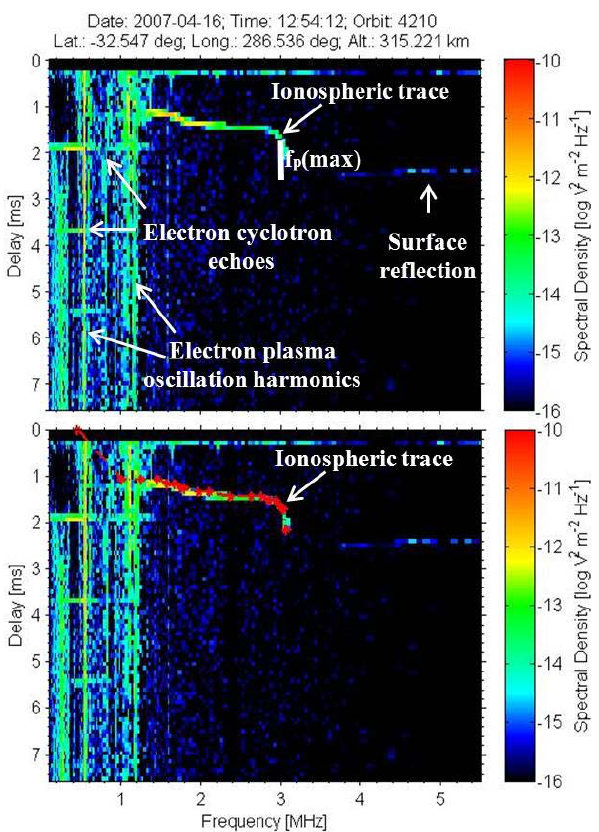
Fig. 1. The top panel shows a typical example of an ionogram ob- tained from MARSIS instrument using MAISDAT tool. The bottom panel emphasizes the identification of the trace for the ionogram reduction. In red it shows the identification of the trace as it is de- scribed in this